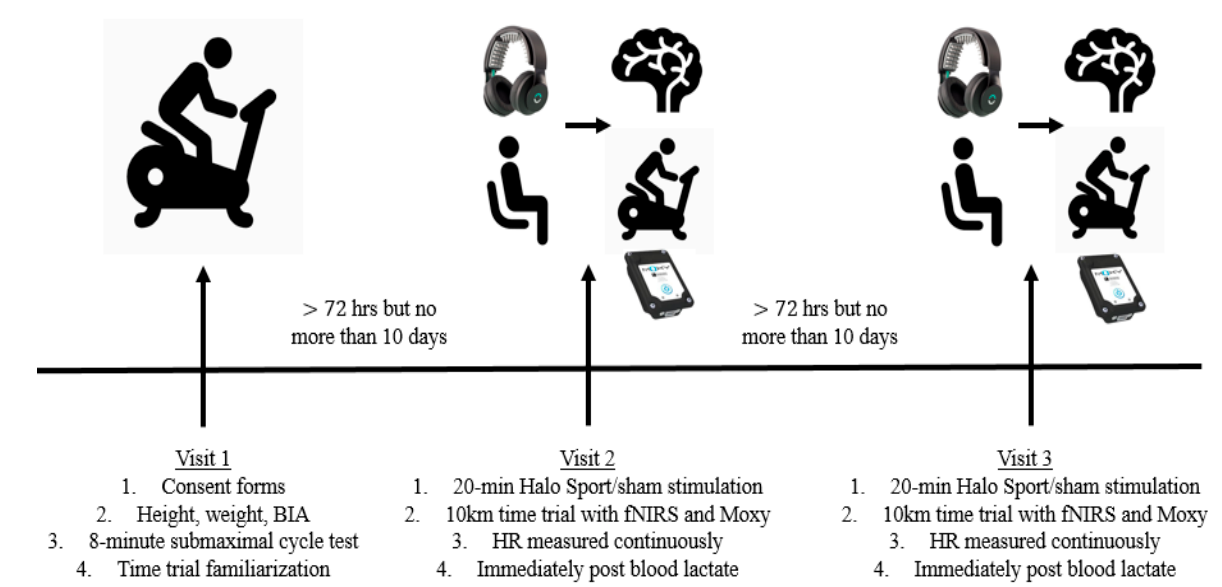
Figure 1. Detailed outline of the study. BIA = bioelectrical impedance analysis, fNIRS = functional near-infrared spectroscopy, HR = heart rate, Moxy = muscle oxygenation device.